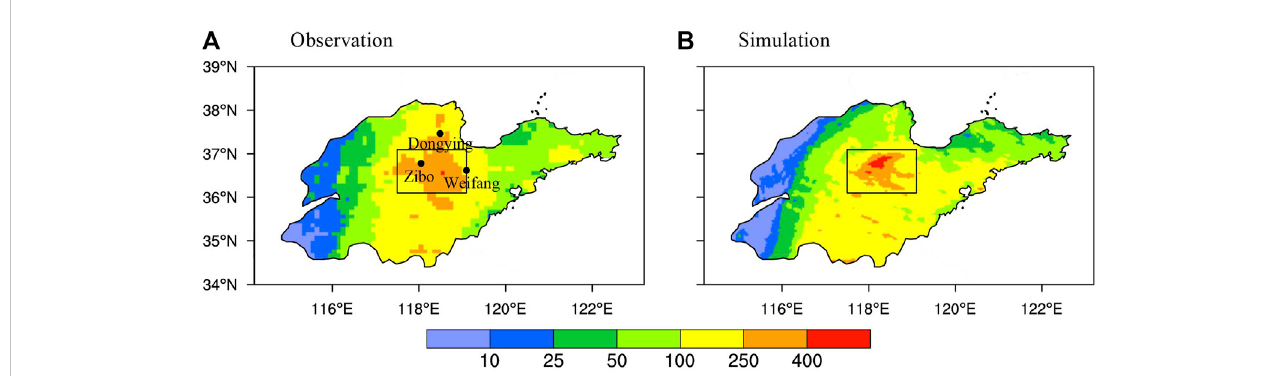
FIGURE 2 Accumulated precipitation (unit: mm) of (A) observation and (B) simulation for Shandong Province from 0000 UTC 10 August to 1200 UTC 11 August 2019. The rectangle zone (36. 1 ° − 37. 1 ° N, 117. 5 ° − 119. 1 ° E) indicated by the black solid box is used to perform the area-averaged time series in Figure 6.